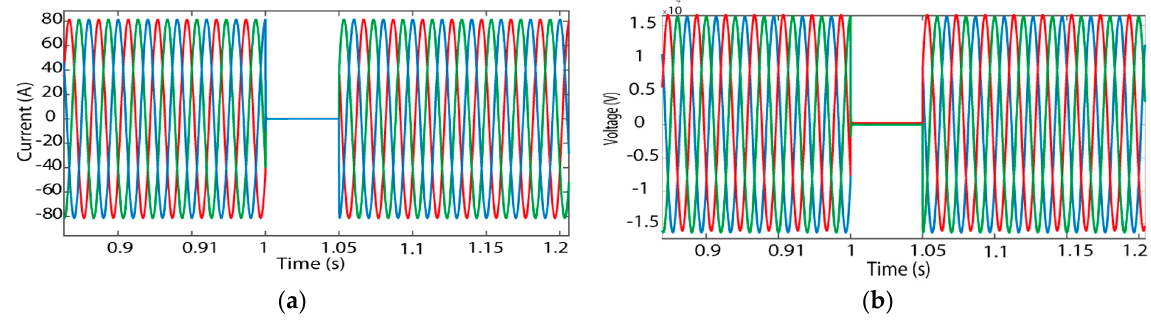
Figure 18. ( a ) Current and ( b ) voltage at load point 3 during reconfiguration.